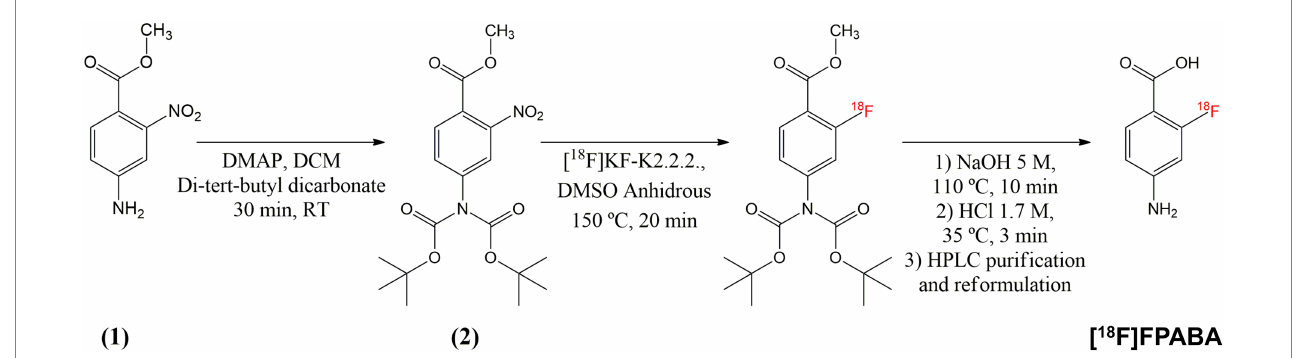
FIGURE 1 Synthesis pathway of [ 18 F]FPABA from commercially available methyl 2-nitro-4-aminobenzoate. Compound (2) was used as the precursor for the automated radioactive